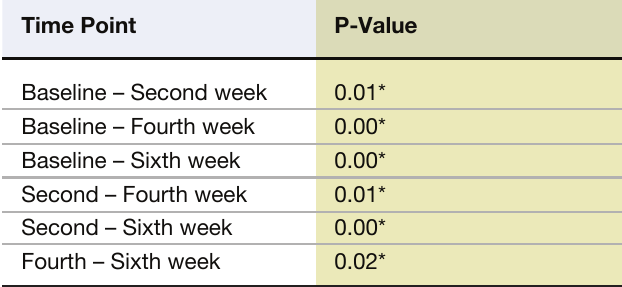
Table 5. Post Hoc Test (Least Square Difference) for Pain Intensity Scores in the Clinic Group across Baseline, Second, Fourth and Sixth Week of Intervention